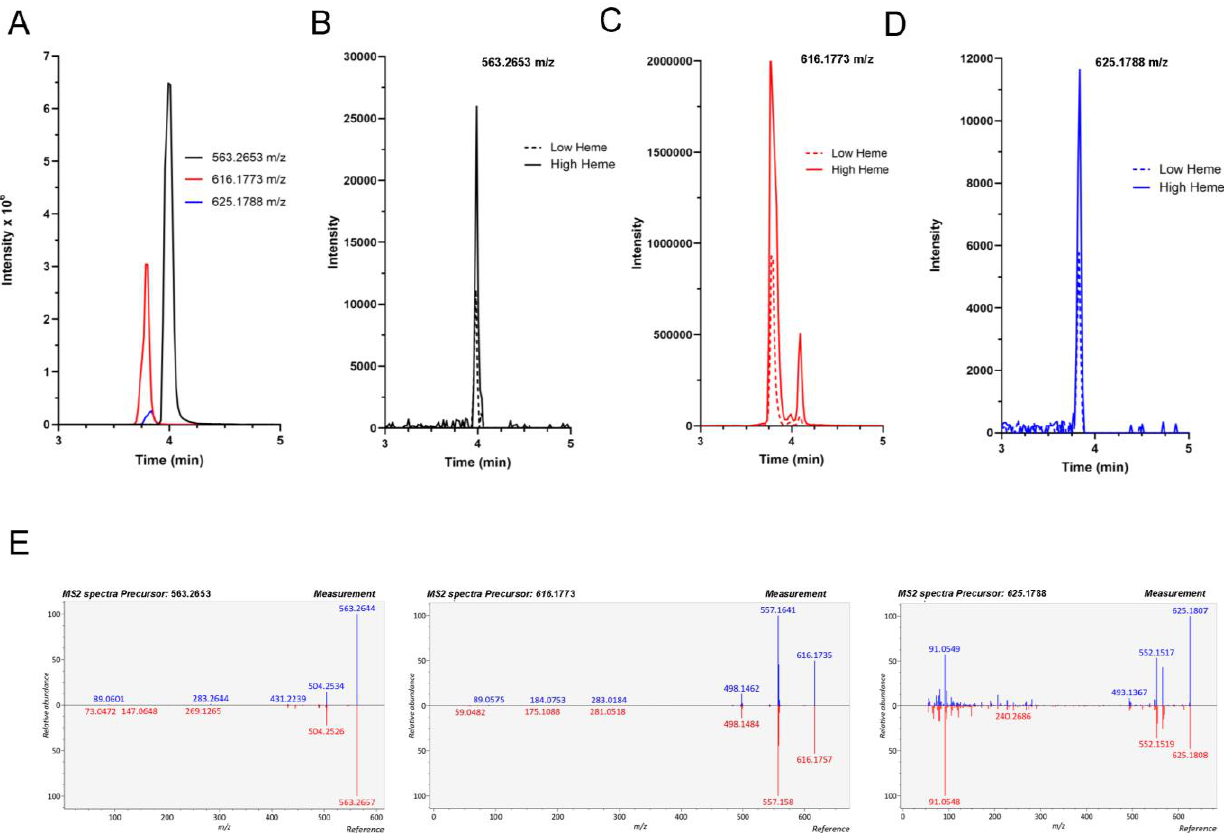
Figure 2. Analysis of pigments extracted from different cooked hams with 80% ( v/v ) acetone/water solution by UHPLC-QTOF-MS. ( A ) Extracted ion chromatograms obtained for a standard mixture of protoporphyrins (100 ng mL −1 ). ( B ) Extracted ion chromatogram of 563.2653 m/z ; ( C ) 616.1773 m/z and ( D ) 625.1788 m/z obtained from pigments extracted from cooked hams made from high heme muscle or low heme muscle. ( E ) Deconvoluted MS/MS spectrum and spectra matching results of PPIX (left), FePPIX (centre) and ZnPPIX (right) yielding dot-product scores of 0.984, 0.954 and 0.960, respectively.